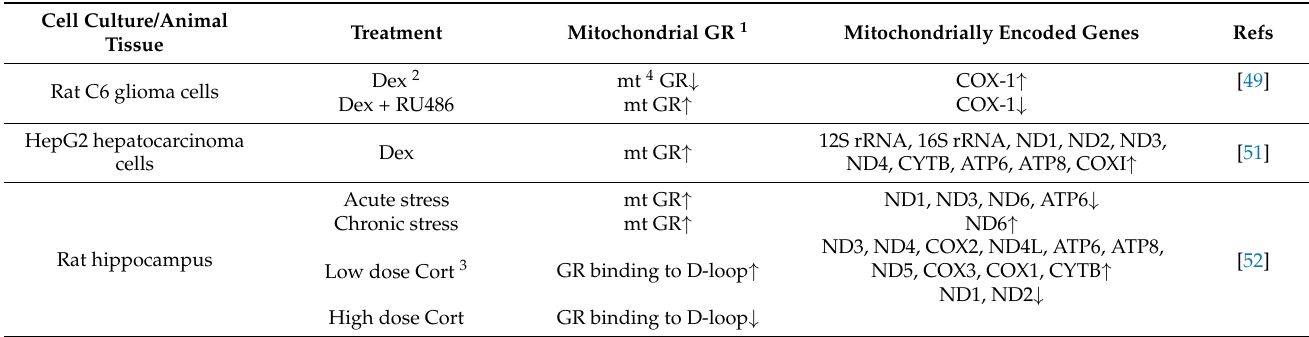
Table 1. Mitochondrial GR localization in parallel with alterations in the expression of the mitochondrially encoded genes. Cell Culture/Animal Tissue